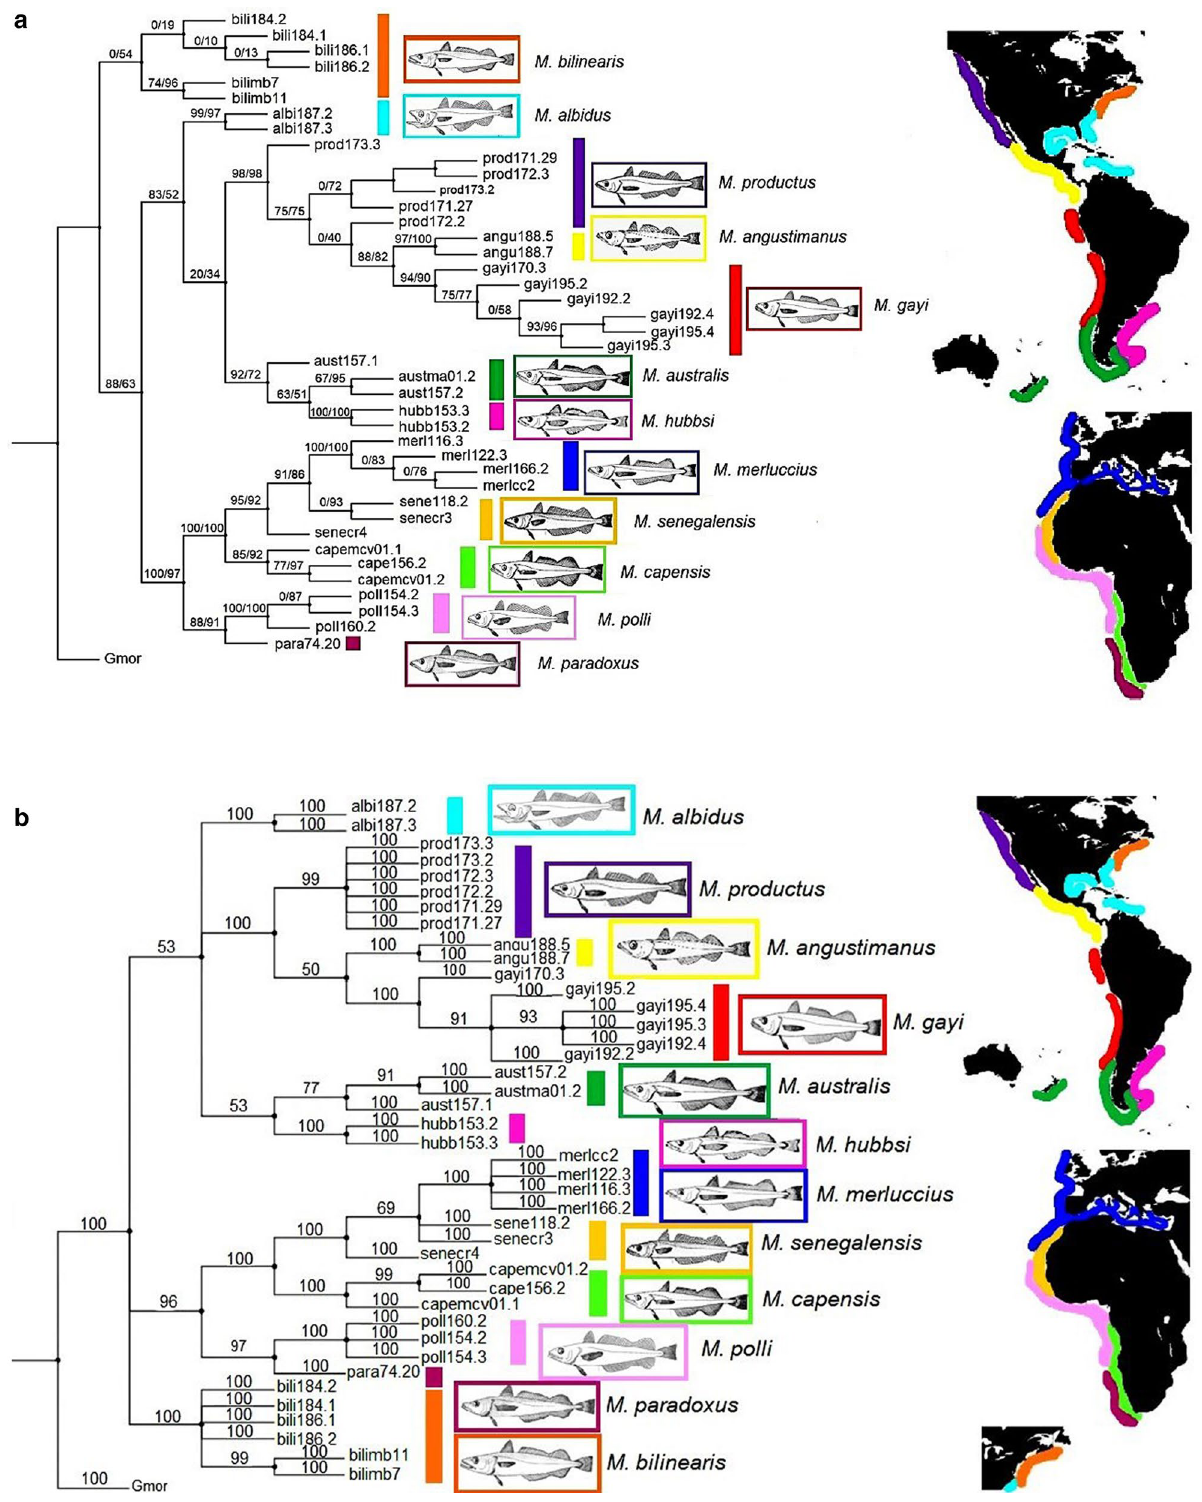
Figure 2. Phylogeny of genus Merluccius spp. comprising 11 valid species and M. angustimanus as built with concatenated sequences from ITS1-rDNA (HKY85 + I + G substitution model) and cyt b (GTR + G substitution model), ( a ) Maximum likelihood tree (- lnL = -4244.841) from IQ-TREE 87 ; supporting values are written on branches (SH-aLRT (%)/ultrafast bootstrap (%)). ( b ) Bayesian tree from MRBAYES v3.2.6 86 ; branches are annotated with bootstrap values, resp. percent posterior probabilities. OTU Gmor corresponds to the outgroup Gadus morhua . Sample codes are given in Table 1 and are followed by the alphanumeric entry code for each specimen in the authors laboratory, e.g. aust_ma01_2 is the specimen No. 2 of sample ma01 from M. australis (aust). The maps have been modified after 13